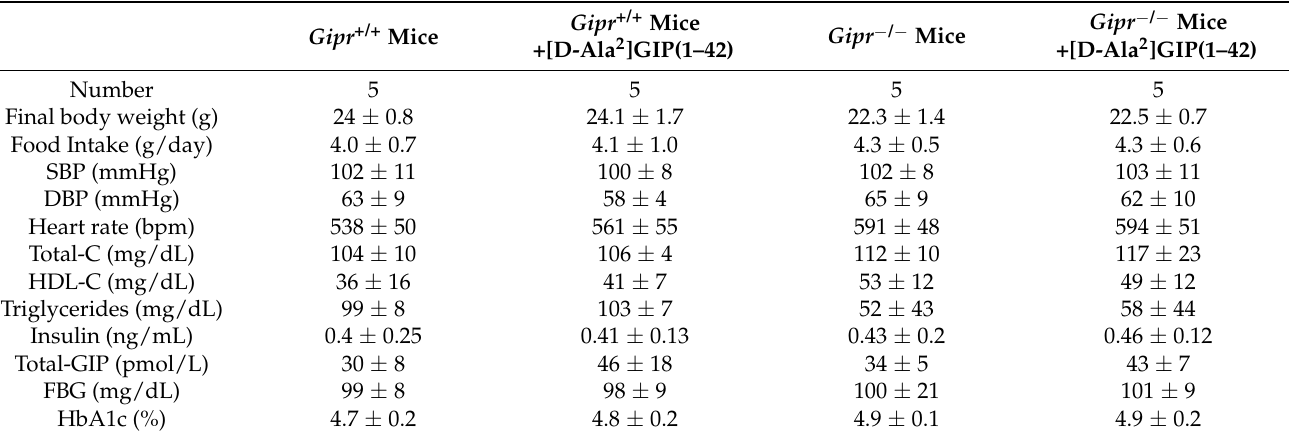
Table 1. Laboratory characteristics of Gipr − / − mice and Gipr +/+ mice at 13 weeks old. Gipr − / − Gipr +/+ Mice Gipr − / − Mice Gipr +/+ Mice +[D-Ala 2 ]GIP(1–42)